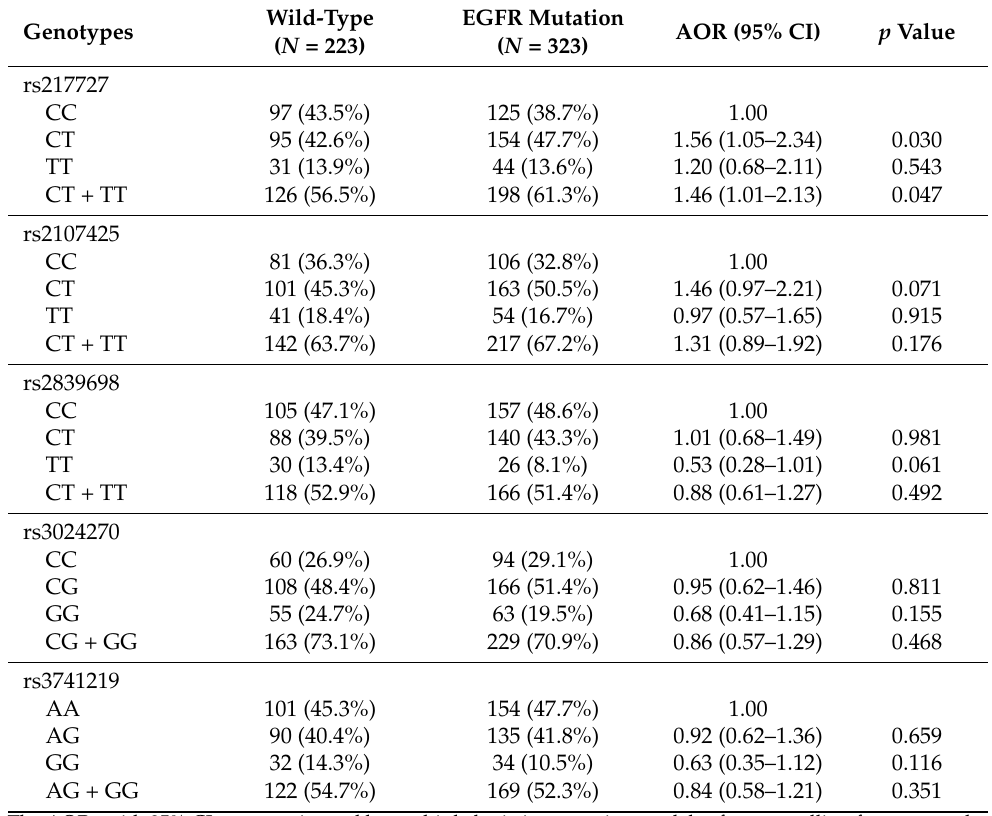
Table 2. Distribution frequency of H19 genotypes of patients with lung adenocarcinoma and multiple logistic regression analysis of EGFR mutation association.